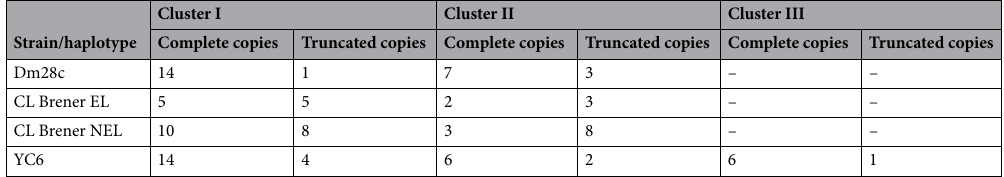
Table 1. Number of cruzipain copies per cluster in Dm28c, CL Brener, and YC6